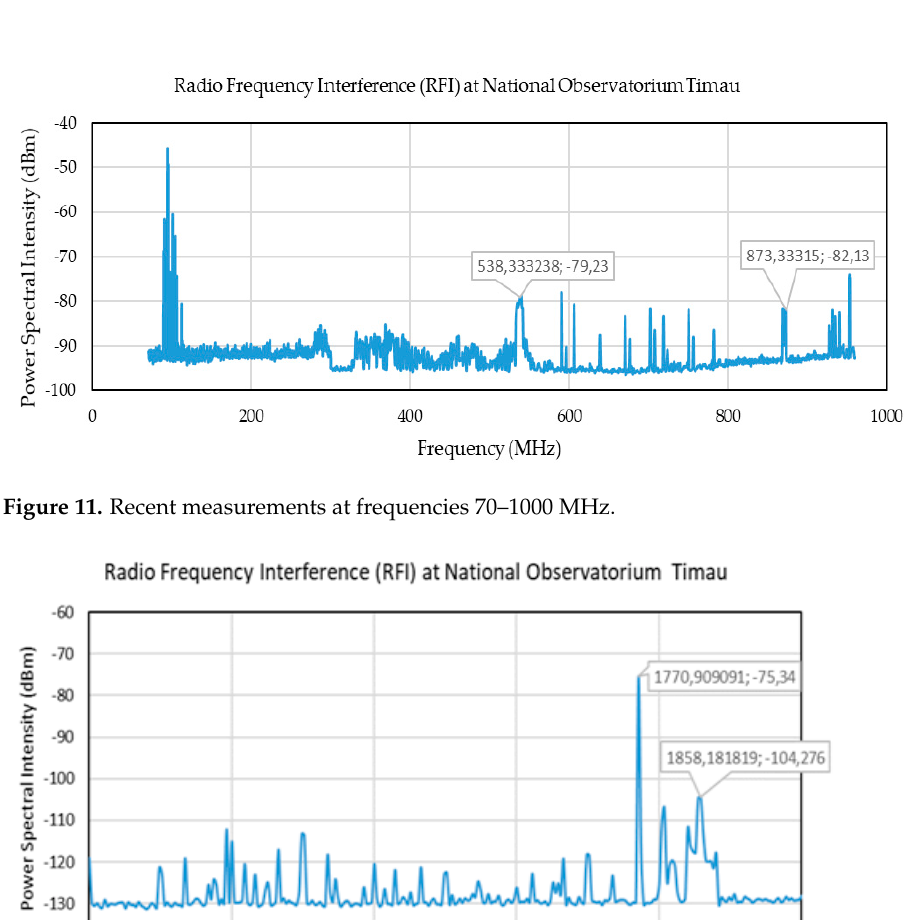
Figure 10. Results of radio frequency measurement at the following frequencies: ( a ) between 4000 and 7000 MHz, using a log-periodic antenna; ( b ) between 5000 and 7000 MHz, using a dipole antenna.